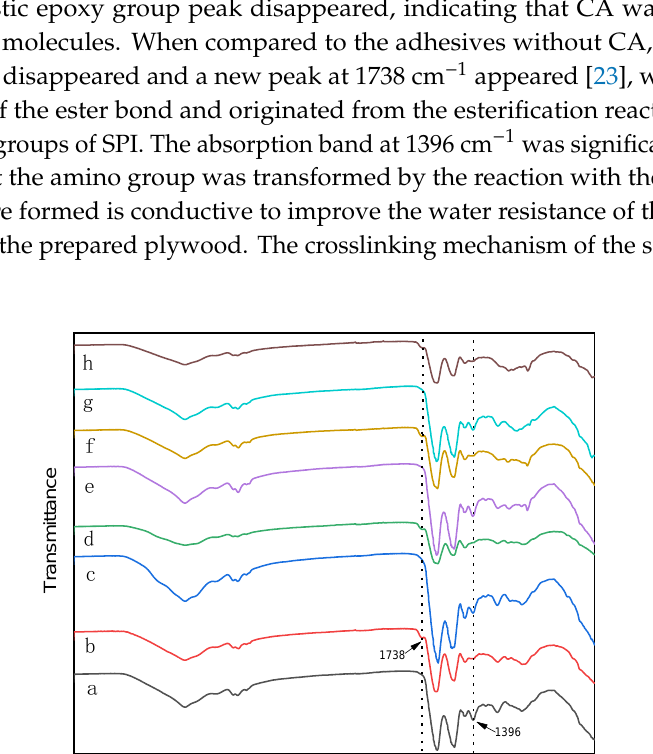
Figure 8. ATR-FTIR spectroscopic of the cured adhesive samples: ( a ) SPI adhesive, ( b ) SPI - CA adhesive, ( c ) SPI-Urea (U) adhesive, ( d ) SPI-Urea-CA adhesive, ( e ) SPI-SDS adhesive, ( f ) SPI-SDS-CA adhesive, ( g ) SPI-SHS-CA adhesive, and ( h ) SPI-SHS-CA adhesive.